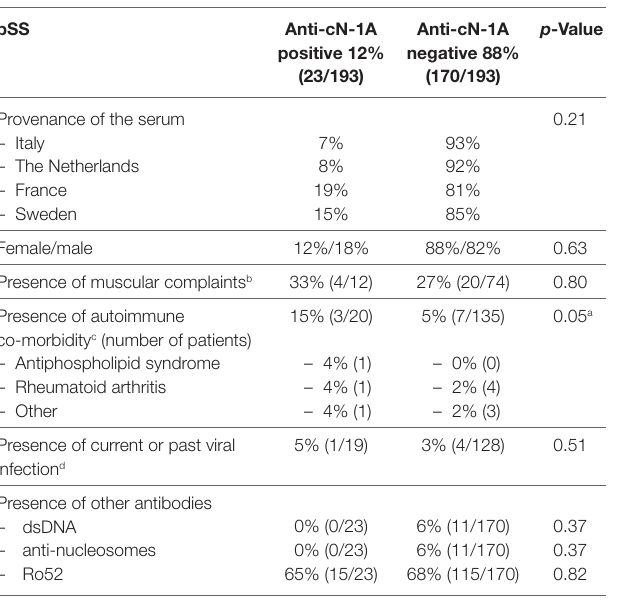
Table 1 | Clinico-demographic correlations: anti-cN-1A in primary Sjögren’s syndrome (pSS).